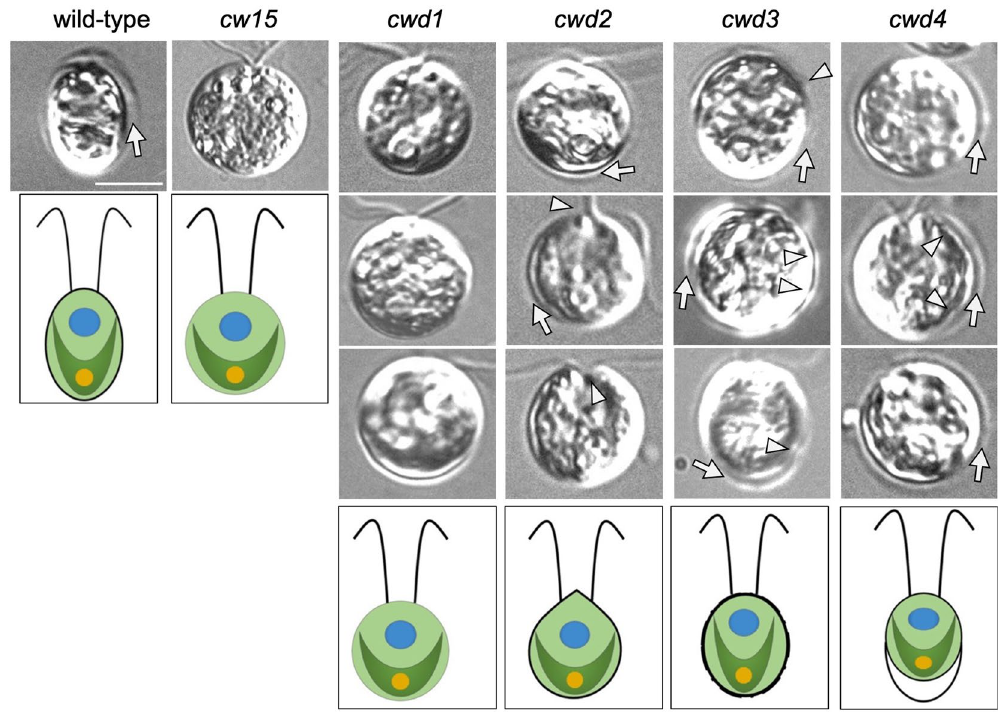
Figure 5. Phenotypic characteristics of wild-type and selected cell wall defective mutant lines. One to three representative micrographs per cell strain are given in columns (labeled above). Arrows indicate cell walls. Arrowheads point to strain-specific anomalies: cwd2 with pointy or collapsed apical cell walls, cwd3 with irregularity of its cell wall, and cwd4 with detachment of the cell wall from the cell body. Scale bar = 5 μ m. For each column, artistic renderings of wild-type and cwd mutant cells illustrating variations in cell wall or lack of cell wall are given at the